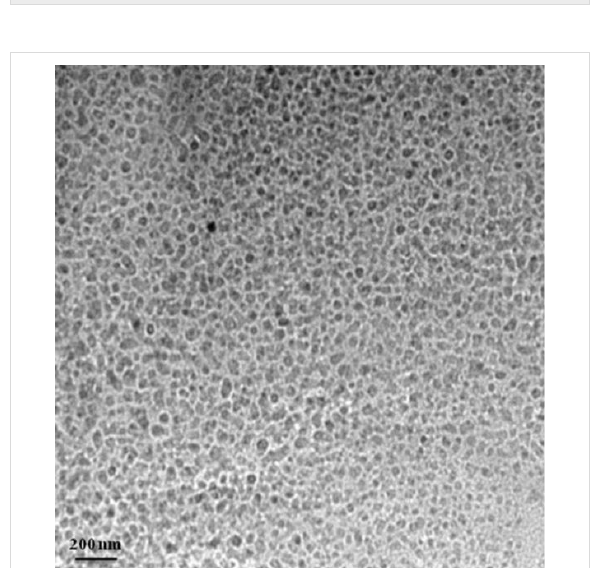
Figure 5: TEM image of the TOPO-coated Ta 2 O 5 nanoparticles. The scale bar corresponds to 200 nm.